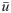
As noise increases, global oscillations accelerate and become gradually more linear.Pre-synaptic noise generically results in a linearization of the neurons response function, altering the network stability and further shaping the frequency of ongoing oscillations. The network mean activity u¯ is shown (top panel) with a close up view of a few cycles (middle panel) with the associated response function (bottom panel), for various levels of noise. A. D = 0.001. B. D = 0.01. C. D = 0.1. Other parameters are identical to parameters used in Fig 1.